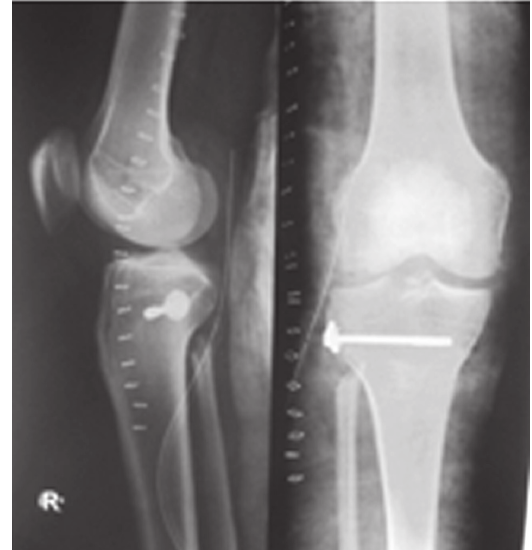
Figure 2. X-ray right knee AP/Lat. View-Excised fibular